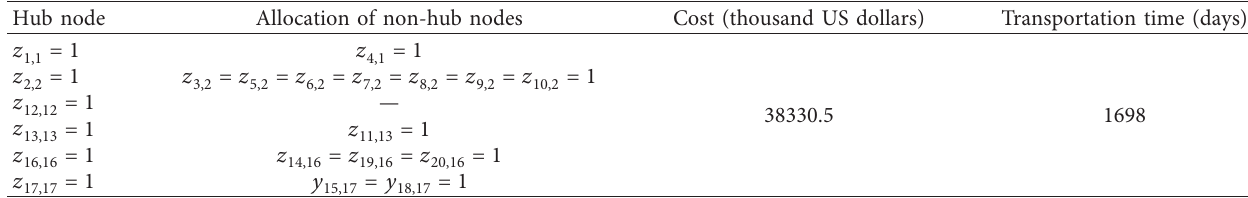
Table 14: Relationship between non-hub and hub when using function f